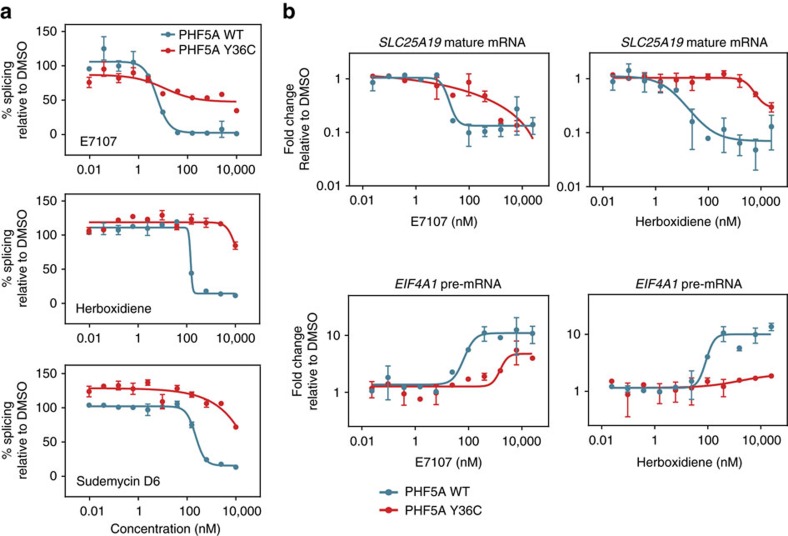
PHF5A-Y36C protects against splicing modulator induced mis-splicing.(a) In vitro splicing assay in the presence of indicated splicing modulators in nuclear extracts containing WT or Y36C PHF5A. Error bar indicates s.d., n=4. (b) Taqman gene expression analysis of mature SLC25A19 mRNA levels and EIF4A1 pre-mRNA levels in either WT- or Y36C PHF5A-expressing cells treated with indicated splicing modulators. All data points were normalized to the corresponding DMSO-treated control samples and displayed in logarithmic scale on the y axis. Error bar indicates s.d., n=2.